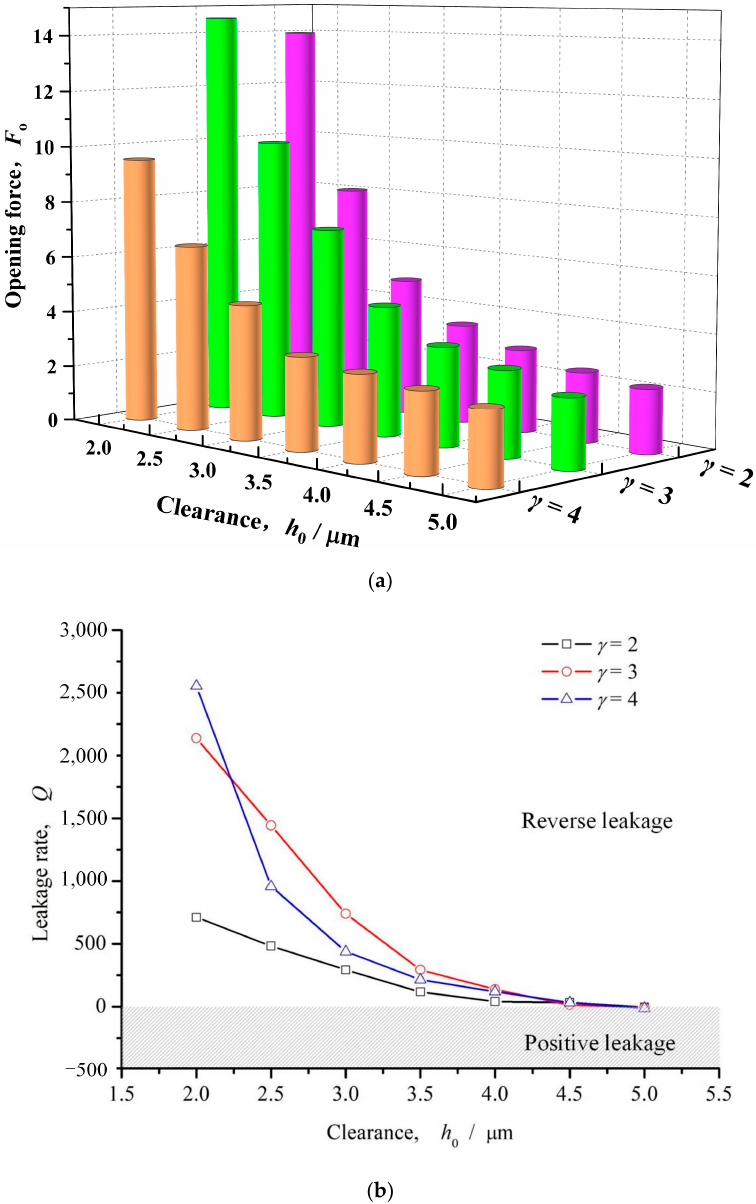
Figure 8. In fl uence of seal clearance on opening force and leakage rate ( ω = 12,000 rpm, P o = 4, h d = 5 μ m, b = 0.20 mm, γ = 3, α = 40°, N = 80). ( a ) Opening force; ( b ) Leakage